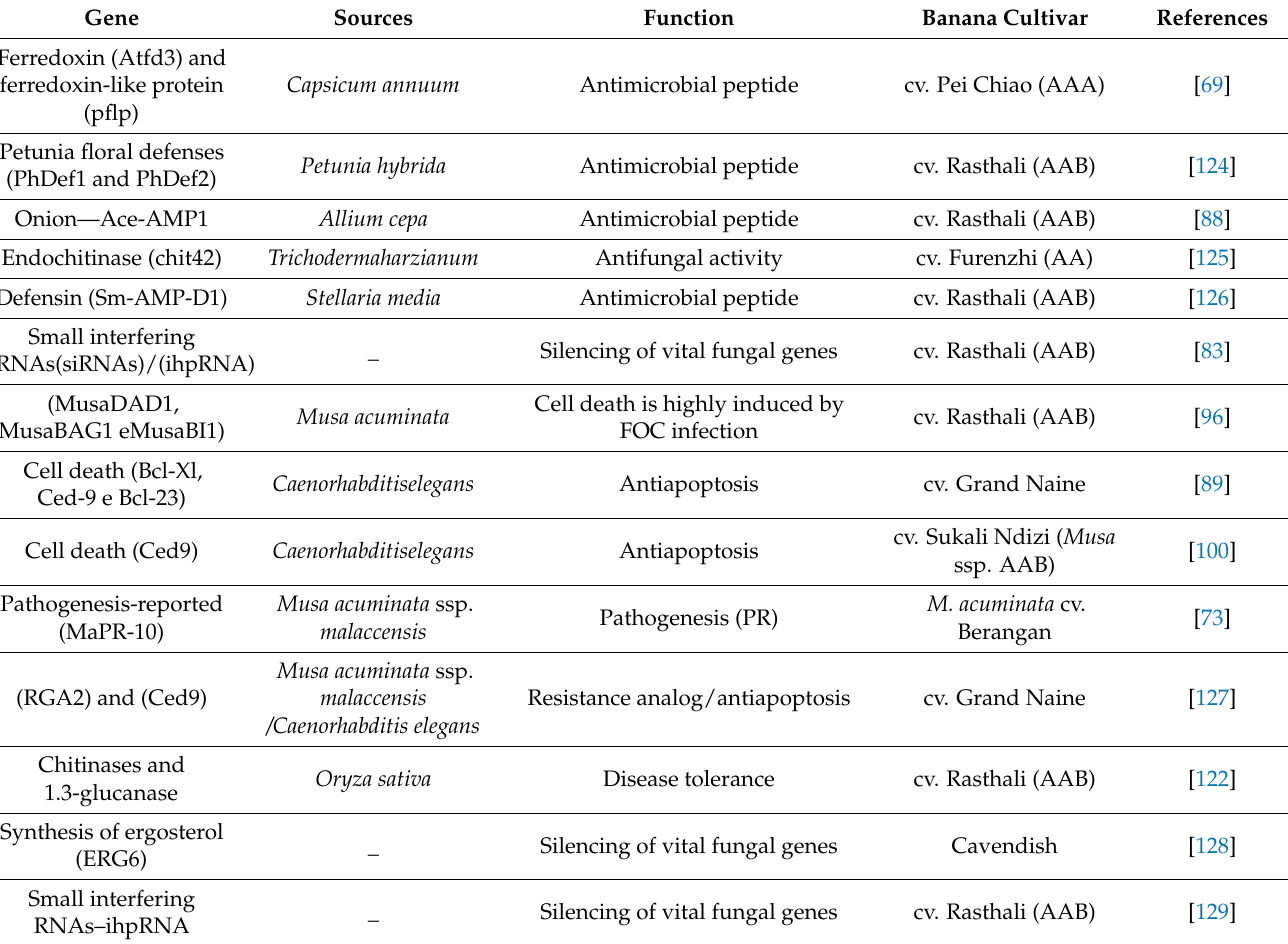
Table 7. Genes used transgenics in studies on genetic improvement of banana to Fusarium wilt in the last ten years.